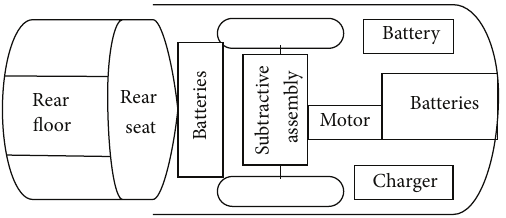
only transform in a small area. Compared with the prototype vehicle, the E-REV weight is increased about 270 kg.